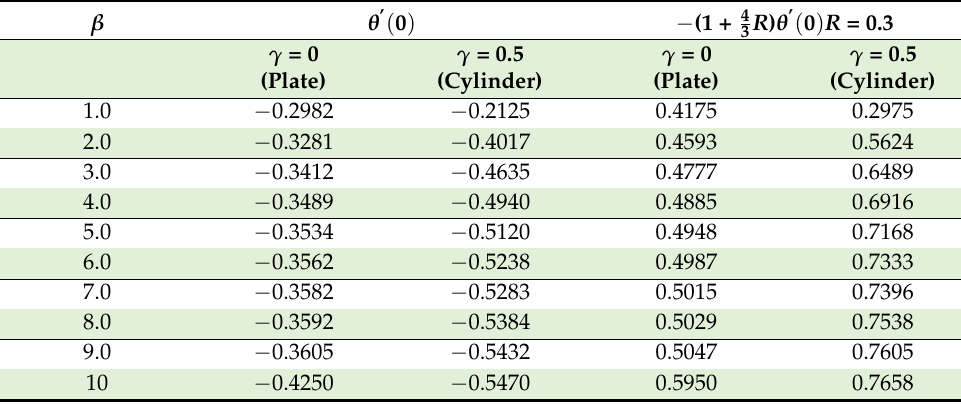
Table 8. Effect of β on Nusselt number when H =